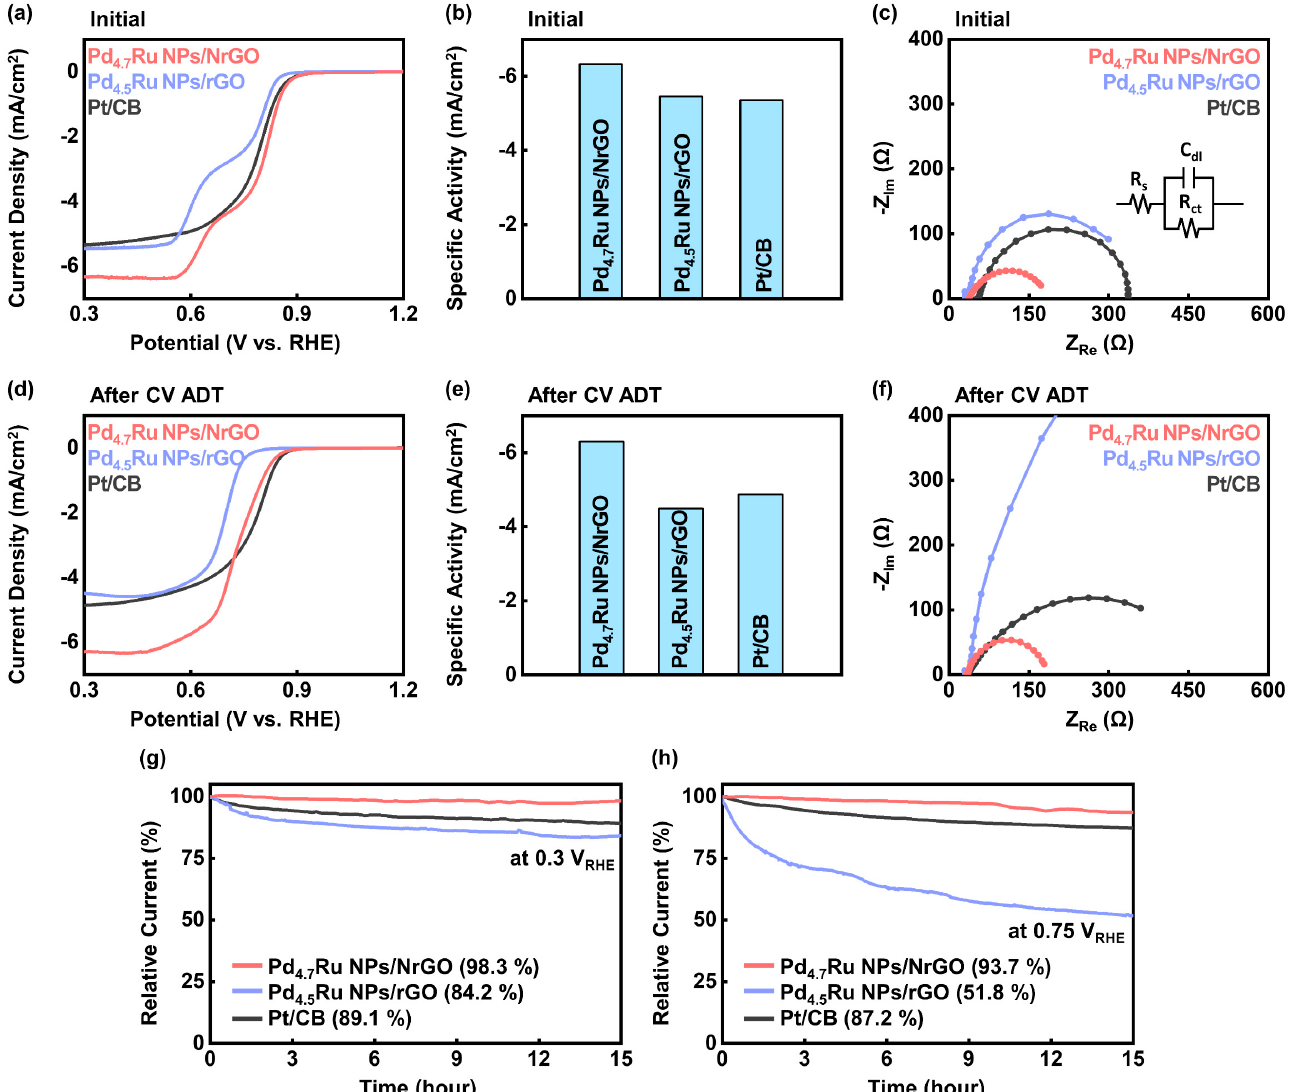
Figure 5. Electrochemical measurement for ORR. LSV curves of the ( a ) initial and ( d ) after CV ADT of the Pd 4.7 Ru NPs/NrGO, Pd 4.5 Ru NPs /rGO and corresponding ( b ), ( e ) specific activities at 0.3 V RHE . ElS curves of the ( c ) initial and ( f ) after CV ADT of the Pd 4.7 Ru NPs/NrGO, Pd 4.5 Ru NPs/rGO, and Pt/CB at the potential of 0.3 V RHE . CA curves of the Pd 4.7 Ru NPs/NrGO, Pd 4.5 Ru NPs/rGO, and Pt/CB at ( g ) 0.3 V RHE and ( h ) 0.75 V RHE .